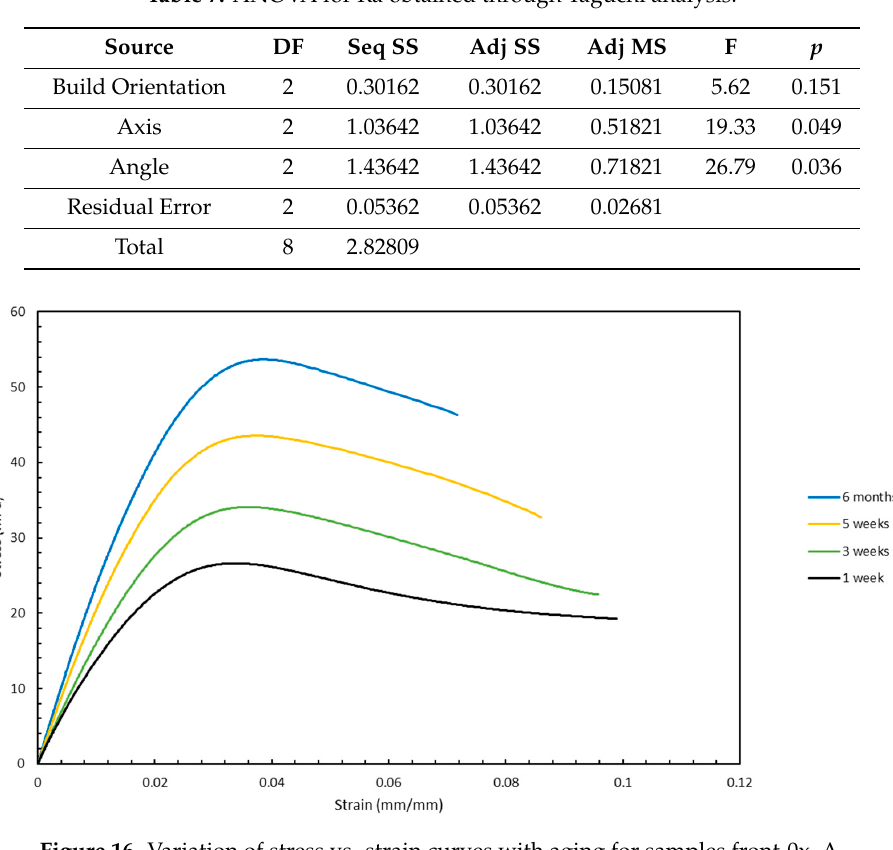
Table 7. ANOVA for Ra obtained through Taguchi analysis.